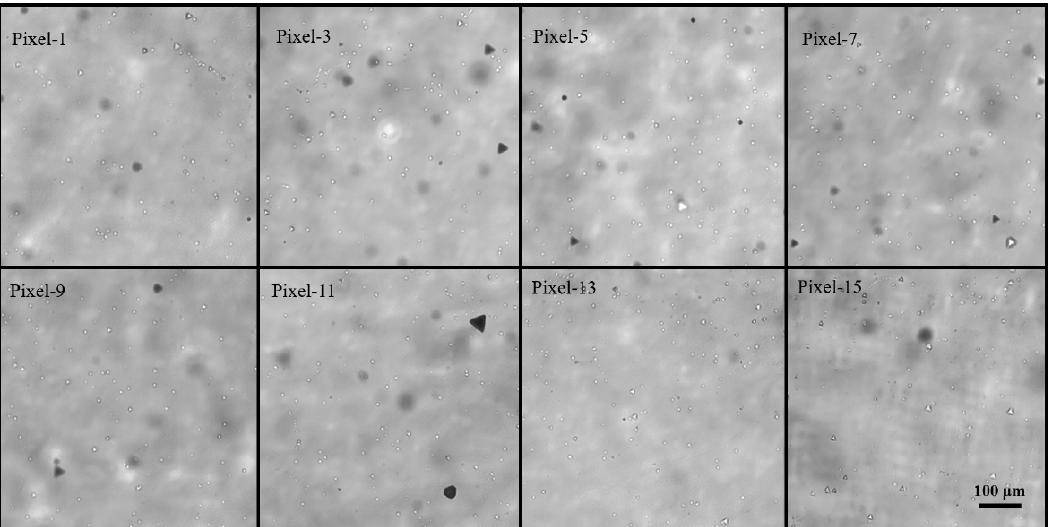
Figure 6. IR transmission microscopy images of the dislocation etch pits at the typical pixel regions of 16-pixel photon counting detectors. Note that the observation face is the {111} Te face and the dislocation etchant is the Everson solution.